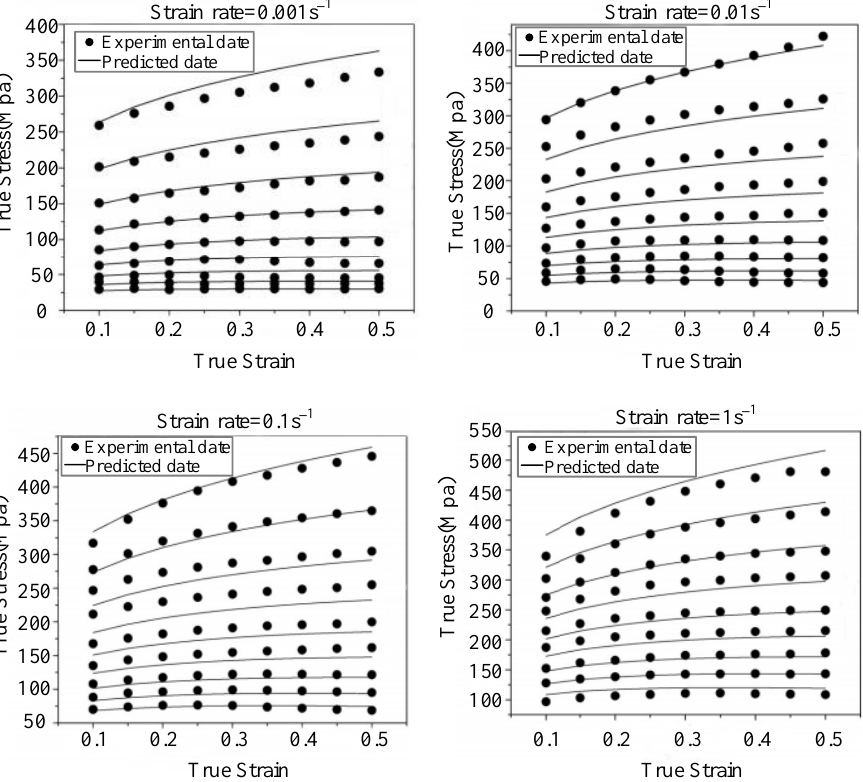
Figure 17. The predicted flow stresses of D9 alloy based on the Samantaray modified model [41].